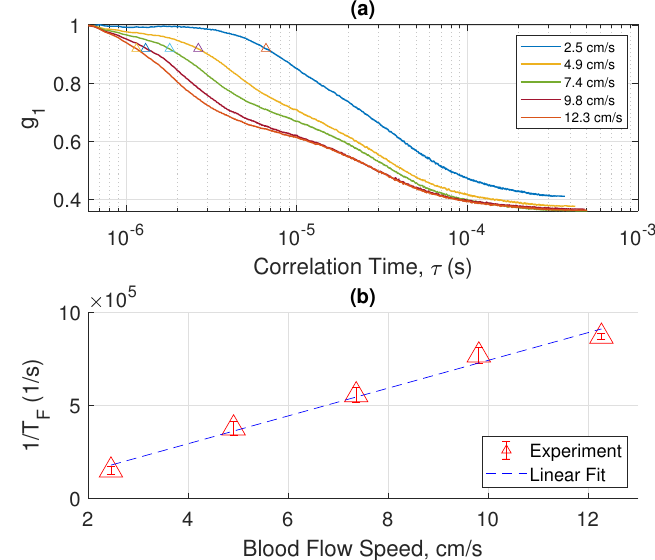
Figure 4. ( a ) Measured E-field correlation function ( g 1 ) versus flow speed of whole blood for a tube diameter of 0.93 mm. ( b ) By taking the inverse of the correlation time at the first inflection point in ( a ), marked using ‘ (cid:77) ’, the decorrelation rate (1/ T F ) is plotted versus the flow speed. The scattered data set with error bars represents the 95% confidence interval over 25 measurements, each for a duration of 1 s. The dashed line is a linear fit of the measured